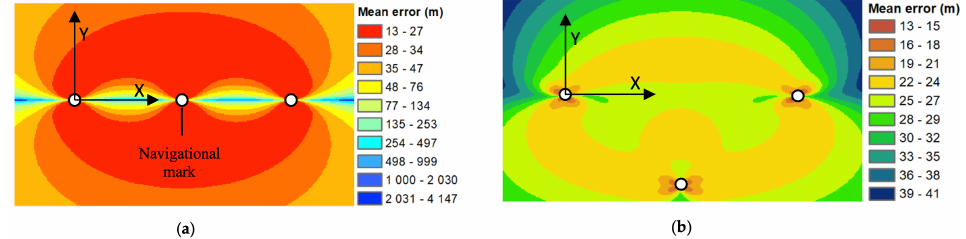
Figure 5. Position accuracy areas are determined by the GLSA method based on relative bear- ings and distances taken relative to three navigation marks aligned: ( a ) in a line, ( b ) in a triangle. ( σ D = 20 m —arbitrarily assumed, σ RG = 0.25 ◦ —assumed based on [30]; the distance between bea- cons is approximately 2600